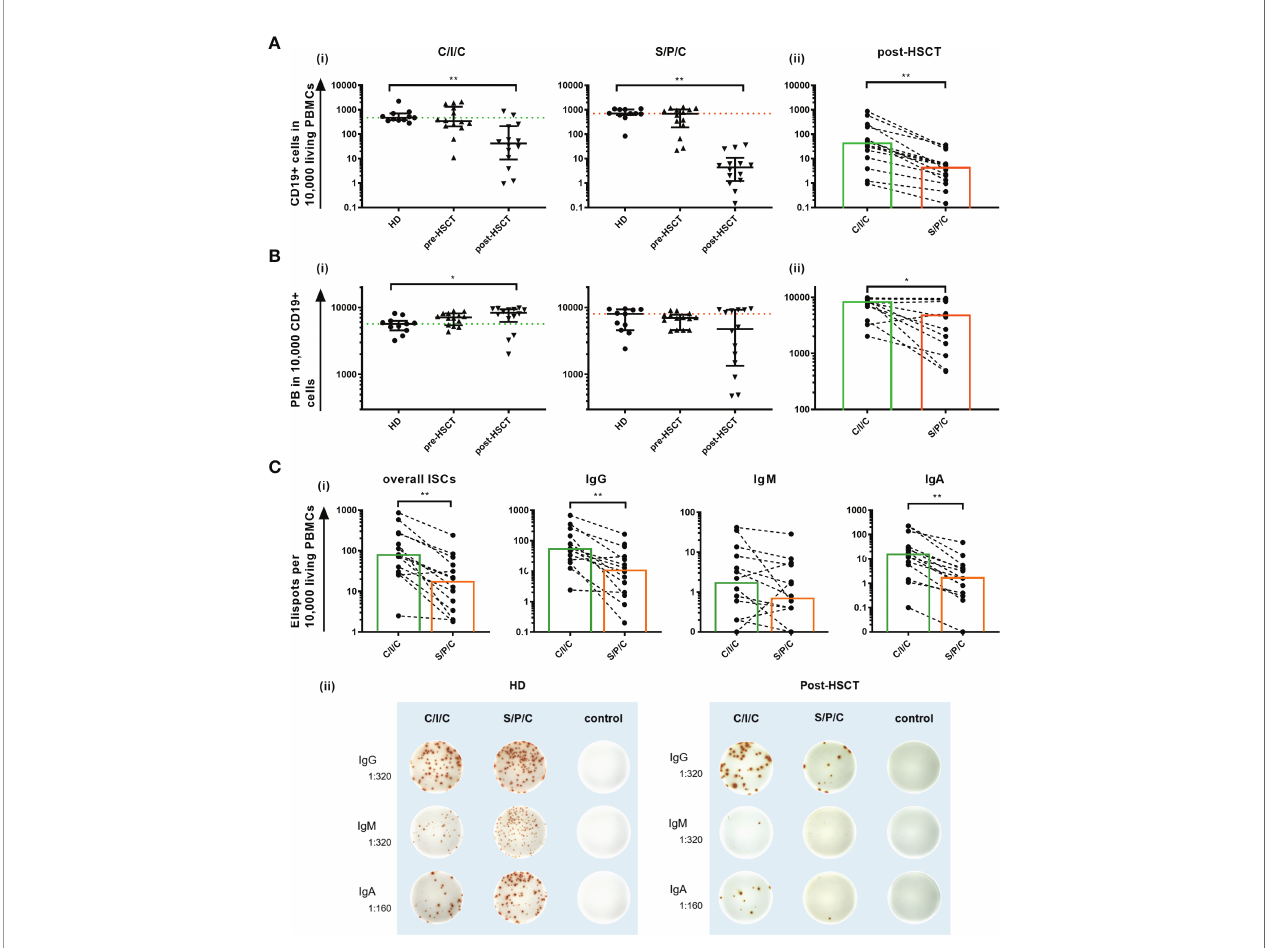
FIGURE 2 | (A) Ex vivo C/I/C stimulation can partially reverse the quantitative B cell defect. (i) Comparison of CD19+ counts/10,000 PBMCs between HD, pre- HSCT and post-HSCT patients measured in fl ow cytometry after either C/I/C or S/P/C stimulation. Mann-Whitney-U tests were performed. Bars represent median ± IQR. The dotted lines mark the median of HDs upon C/I/C (green) or S/P/C (orange). (ii) Post-HSCT measurements of CD19+ cells/10,000 PBMCs upon C/I/C or S/ P/C stimulation were compared with the Wilcoxon test. Boxes mark the median counts after C/I/C (green) or S/P/C stimulation (orange). All graphs in (A – C) are plotted on a log 10 scale and *p < 0.05, **p < 0.001. (B) Differentiation to PBs is hampered after S/P/C stimulation post-HSCT, but appears functional after C/I/C stimulation. (i) The differentiation into PBs is evaluated by analyzing PBs per 10,000/CD19+ cells measured by fl ow cytometry upon C/I/C or S/P/C stimulation. Mann-Whitney-U tests were performed for comparing HD and patients. The dotted lines mark the median of HDs upon C/I/C (green) or S/P/C (orange). Bars represent the median ± IQR. (ii) Wilcoxon test is applied to compare post-HSCT PBs per 10,000/CD19+ cells between stimulation assays. Boxes mark the median counts after C/I/C (green) or S/P/C stimulation (orange). (C) Differentiation to ISCs is hampered after S/P/C stimulation post-HSCT, but appears regular after C/I/C stimulation. (i) Differentiation into ISCs was assessed by identifying ELISpots per 10,000 added cells, assuming one spot equals one ISC. Here the amount of spots generated upon C/I/C or S/P/C stimulation was compared using the Wilcoxon-test in post-HSCT patients ’ samples. Boxes mark the median counts after C/I/C (green) or S/P/C stimulation (orange). (ii) Representative ELISpot wells of a HD and a post-HSCT patient upon C/I/C or S/P/C stimulation and control wells. Dilutions refer to the amount of PBMCs that were added per